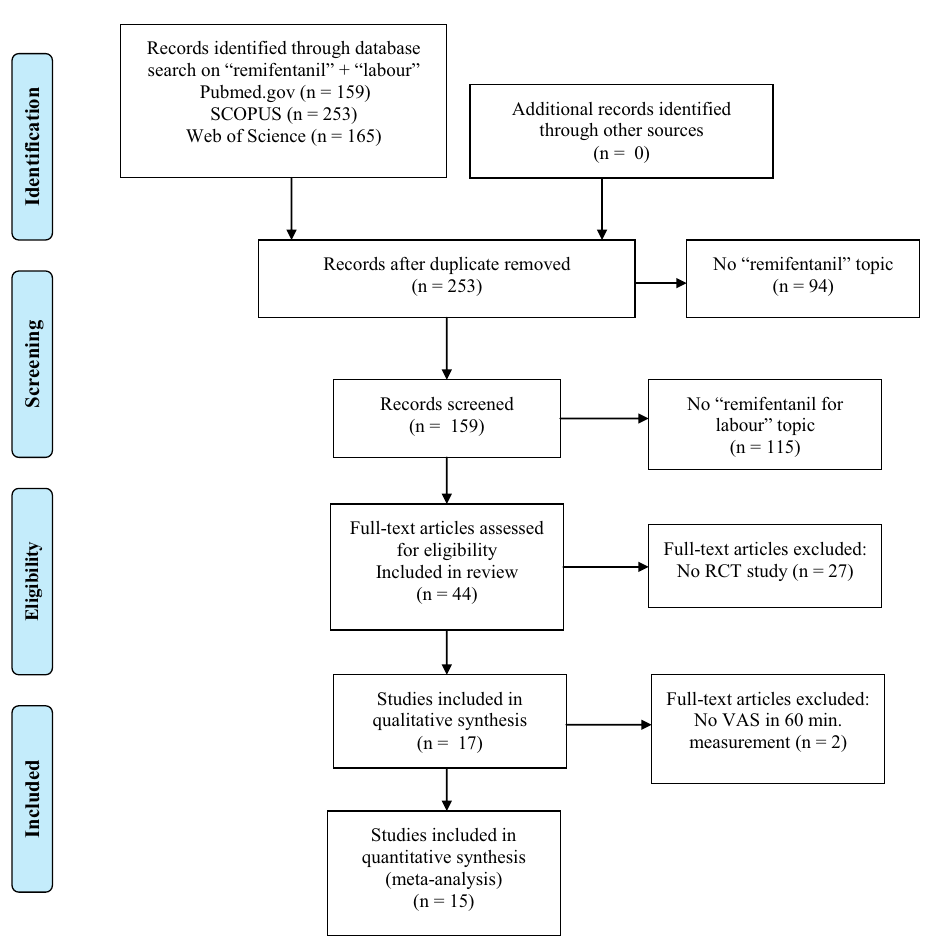
Fig. 1. PRISMA flowchart